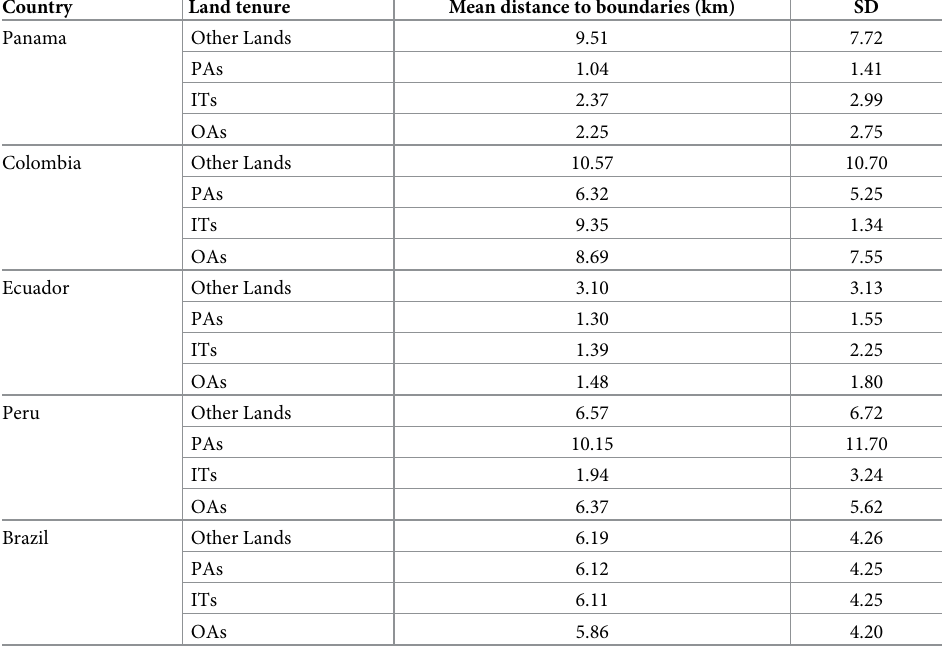
Table 2. Mean distance to ITs’, OAs’, and PAs’ boundaries of observation units sampled through matching analy- sis by country and land tenure.